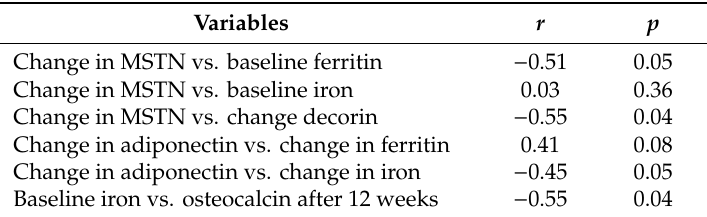
Table 3. Significant Spearman correlation between variables in NW group.